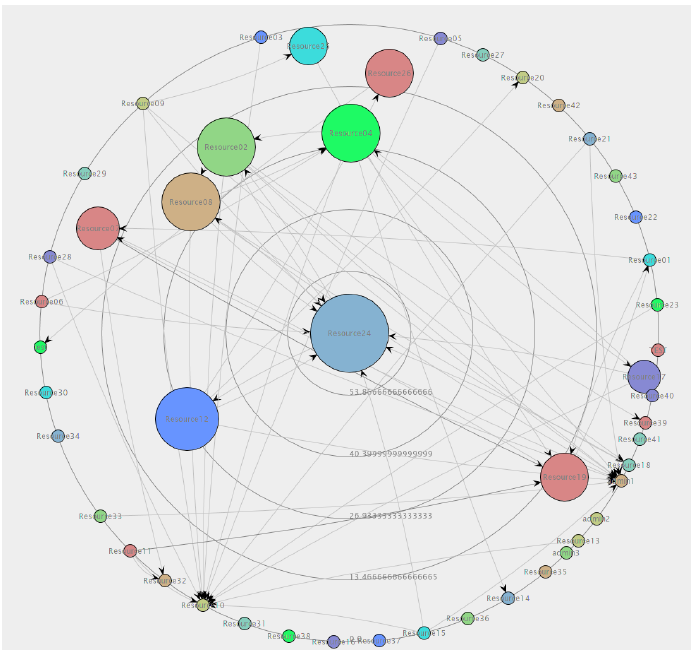
Figure 5. Analysis of the relationship between various resources in the Receipt